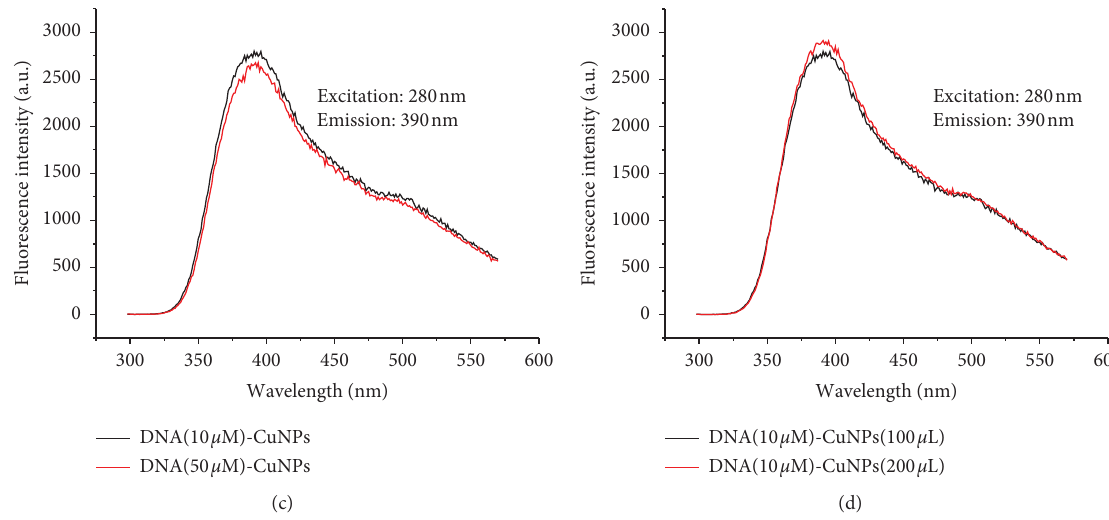
Figure 3: Fluorescence spectra of (a) the influence of DNA to DNA-Cu NPs, (b) the effect of volume to DNA-Cu NPs, (c) effect of reaction environment to DNA-Cu NPs, and (d) the influence of template and reducing agent to copper nanomaterials.